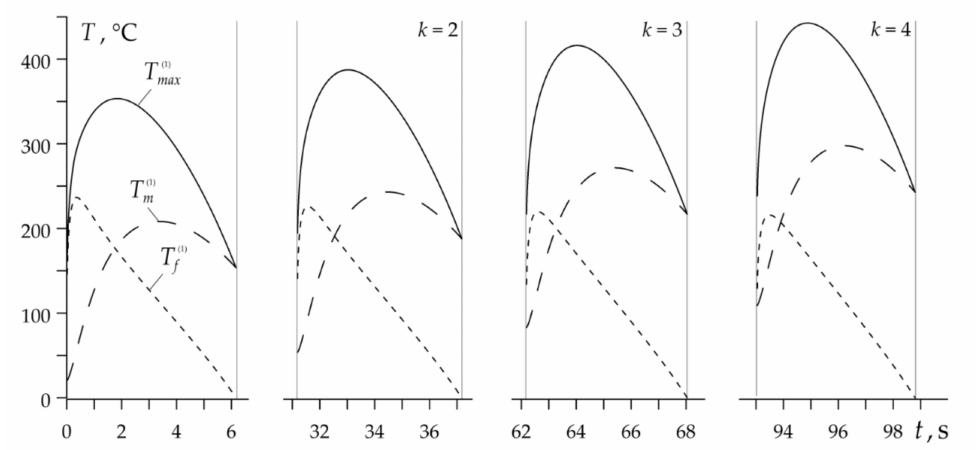
( k ) max (solid lines), mean T